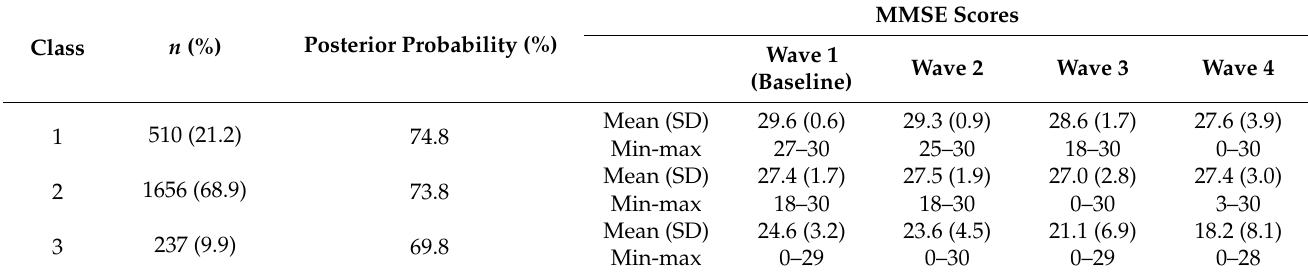
Table 3. Baseline characteristics of individuals in Classes